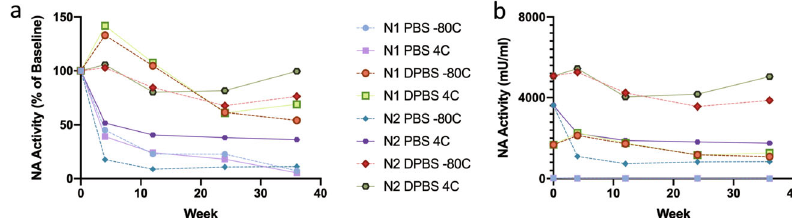
Fig. 1 N1 and N2 NA activity over 36 weeks under different temperature and buffer conditions in vitro. NA activity of N1 and N2 stored in parallel at − 80 °C and 4 °C, in PBS and DPBS (total eight samples), was measured using MU-NANA assay at weeks 0, 4, 12, 24, and 36. Activity presented as a percent ( a ) using week 0 as a baseline or as absolute activity ( b ). Points represent individual samples.